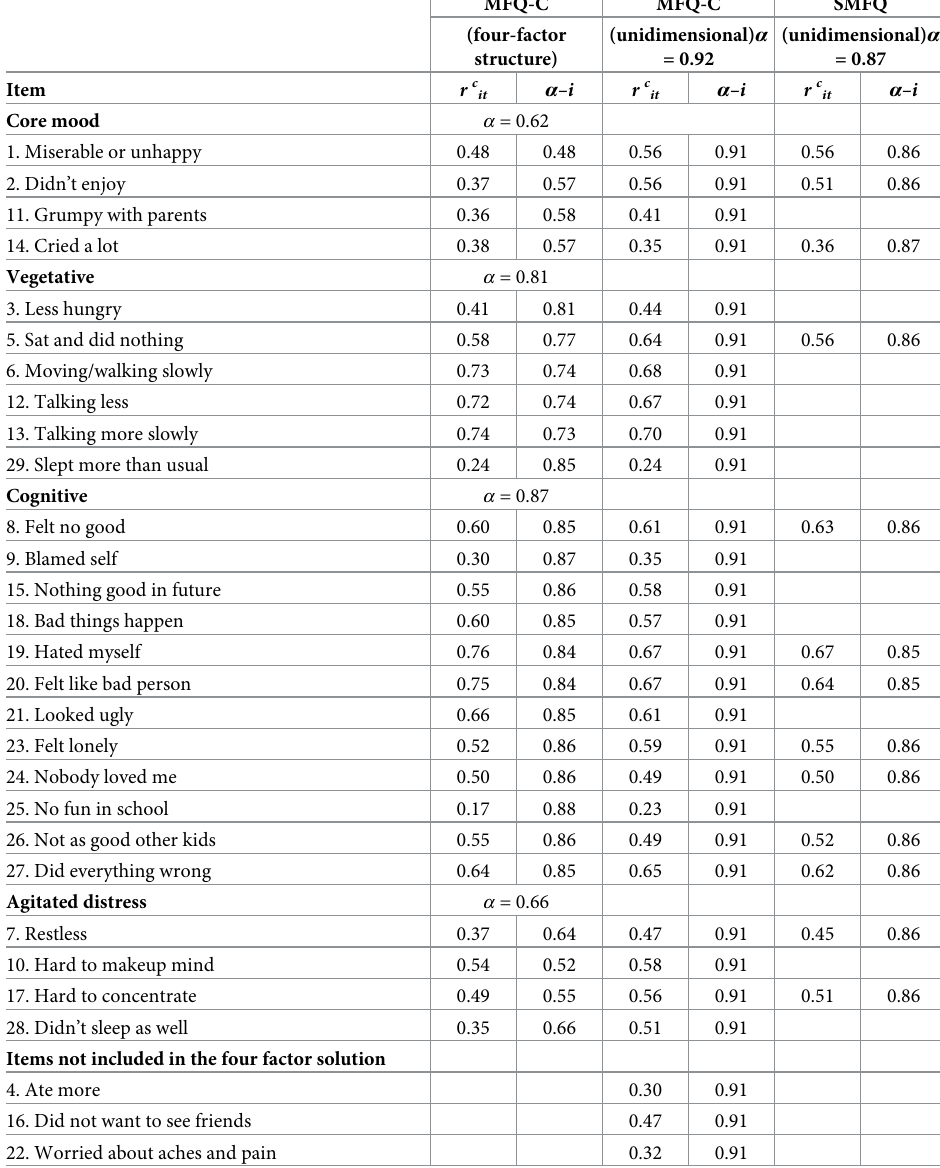
Table 3. Reliability indices for items of the Mood and Feelings Questionnaire and the Short Mood and Feelings